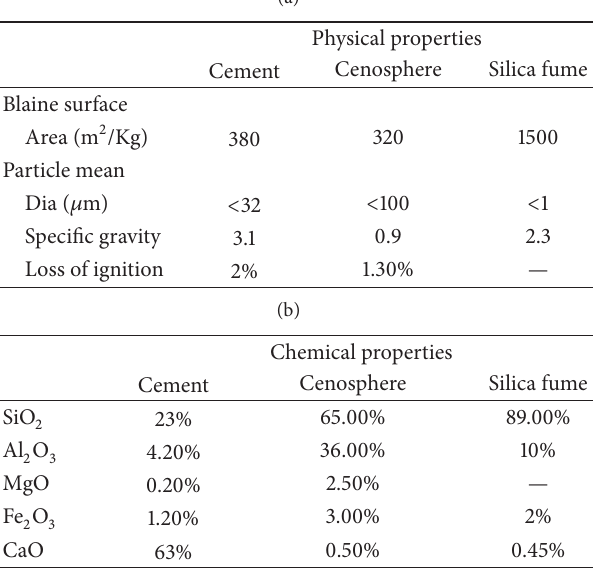
Table 1: Properties of cement, cenosphere, and silica fume.